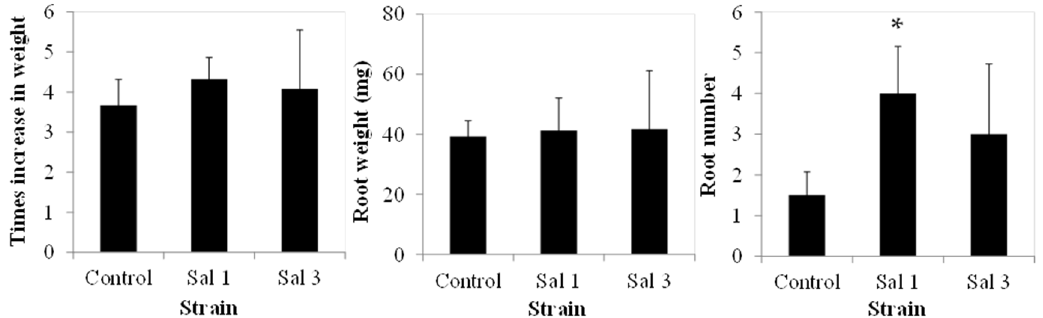
Figure 5. The effect of inoculation with sweet potato endophytes on sweet potato plant growth in nitrogen-limiting conditions in agar tubes. The bars represent standard deviation ( n ≥ 3) and asterisks indicate a significant difference at P < 0.05 by Tukey’s test.